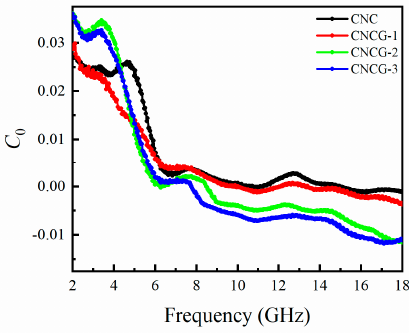
Figure 9. The 𝐶 (cid:2868) curves of all composites. Figure 9. The C 0 curves of all